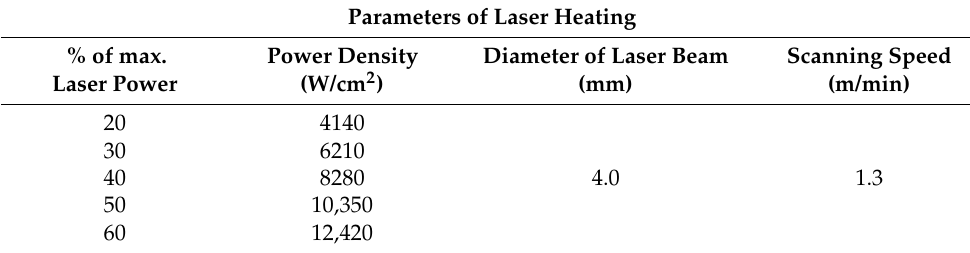
Table 2. Laser heating parameters employed in